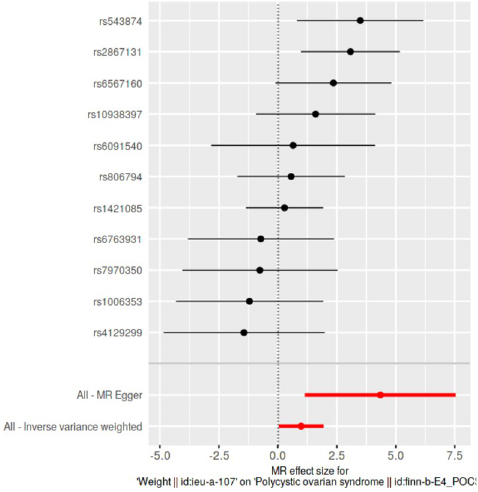
Fig 5. Forest plot of weight, against polycystic ovarian syndrome as the outcome. Effects of individual SNPs and pooled estimates from MR-Egger- and inverse variance weighted methods are visualized.